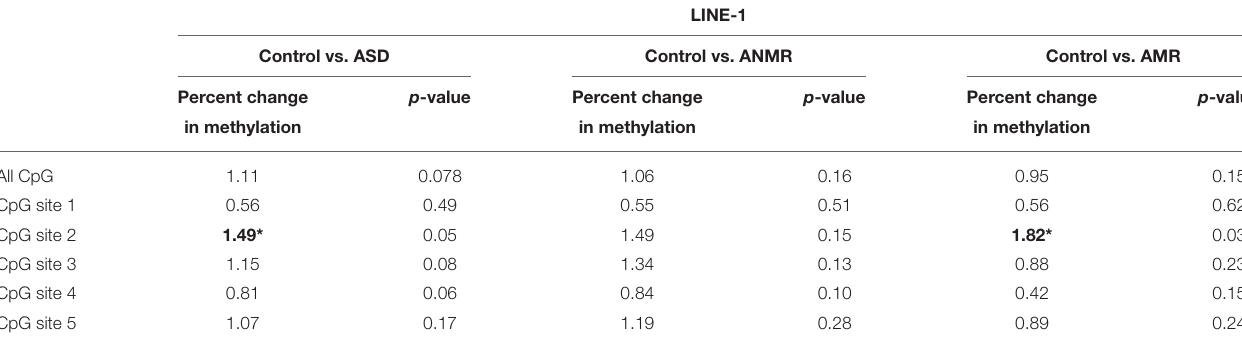
TABLE 3 | Pyrosequencing results of LINE-1 showing percent change in methylation in ASD group, ANMR and AMR subgroups compared to healthy control group. LINE-1 Control vs. ASD Control vs. ANMR Control vs. AMR Percent change p -value Percent change p -value Percent change p